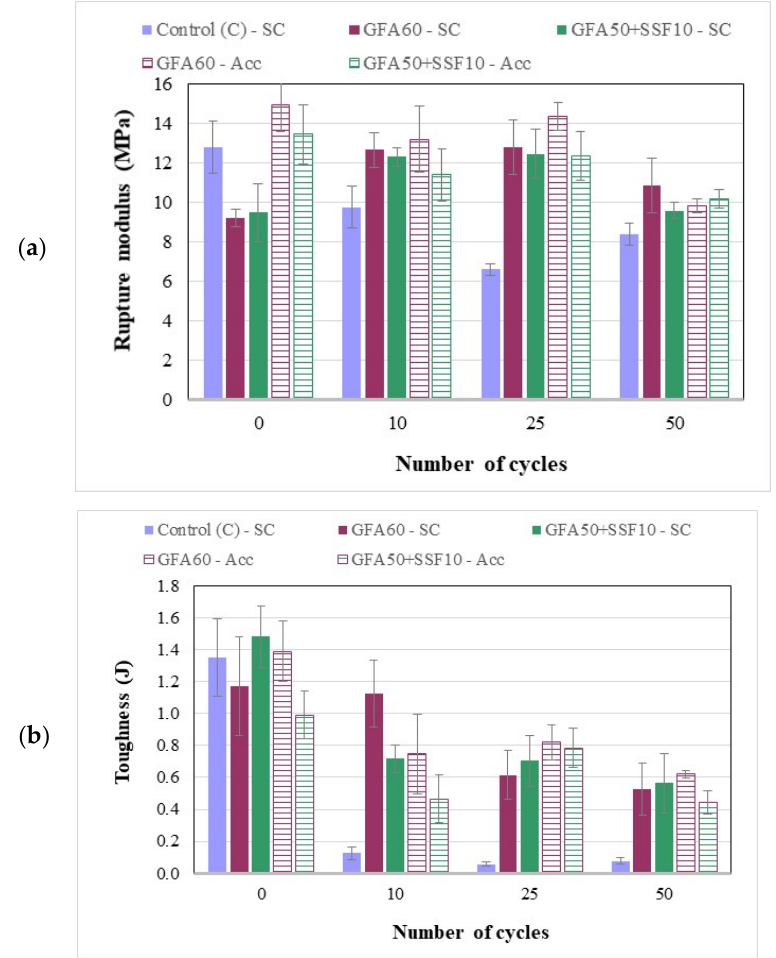
Figure 8. Modulus of rupture ( a ) and toughness ( b ) for the GRC composites subjected to wetting– drying tests in 3.5% NaCl solution.